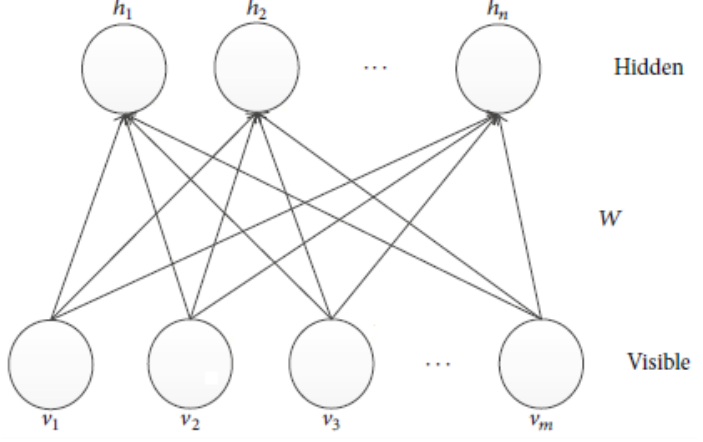
Figure 1. Illustration of a typical DBN structure.